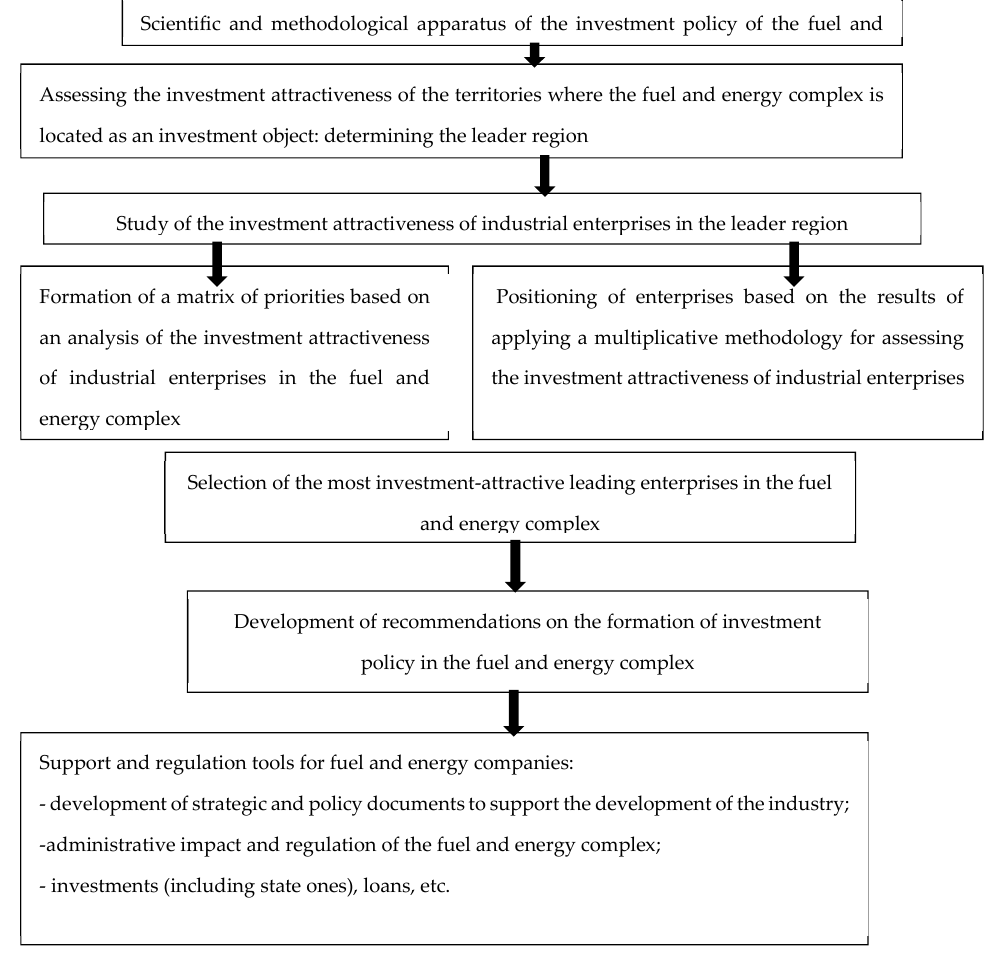
Figure 3. Scheme of visualization of the scientific and methodological apparatus of the investment policy of the fuel and energy complex. Source: developed by Zadimidchenko A.